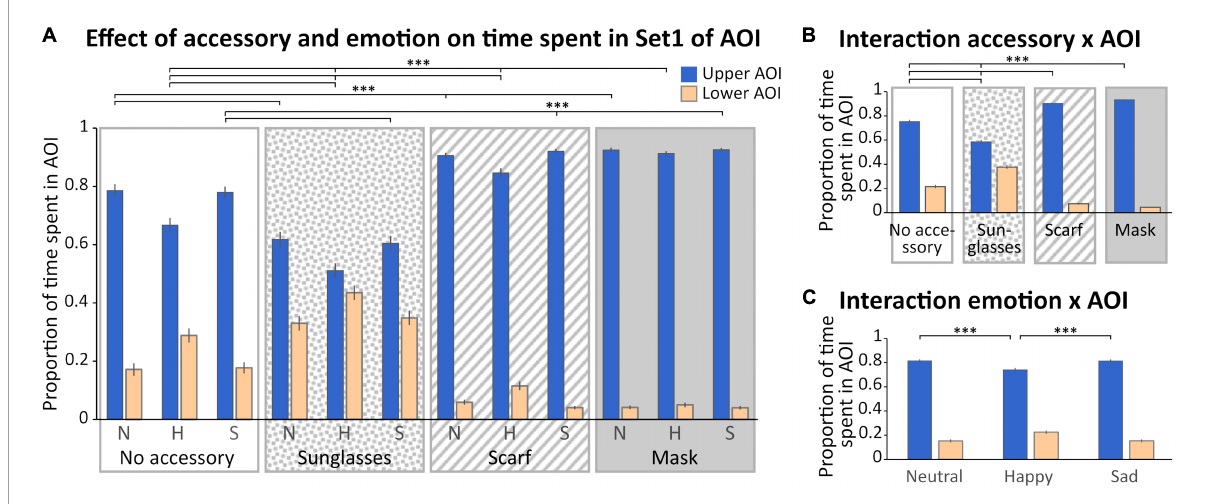
FIGURE3 Analysis of the time spent in Set 1 of AOI. (A) Mean ( ± standard error) of the proportion of time spent (relative to the time spent on the screen) in the Areas of Interest (AOIs) (upper AOI: blue, left columns; lower AOI: yellow, right columns) according to accessory (no accessory: white background; sunglasses: dotted background; scarf: hatched background; mask: gray background) and emotion (neutral: N, happy: H, and sad: S). (B) Mean ( ± standard error) of the proportion of time spent in the AOIs illustrating the accessory × AOI interaction. (C) Mean ( ± standard error) of the proportion of time spent in the AOIs illustrating the emotion × AOI interaction. For sake of clarity, only the significant comparisons for the upper AOI are illustrated. The pattern is identical for the lower AOI. ∗∗∗ p < 0.001.